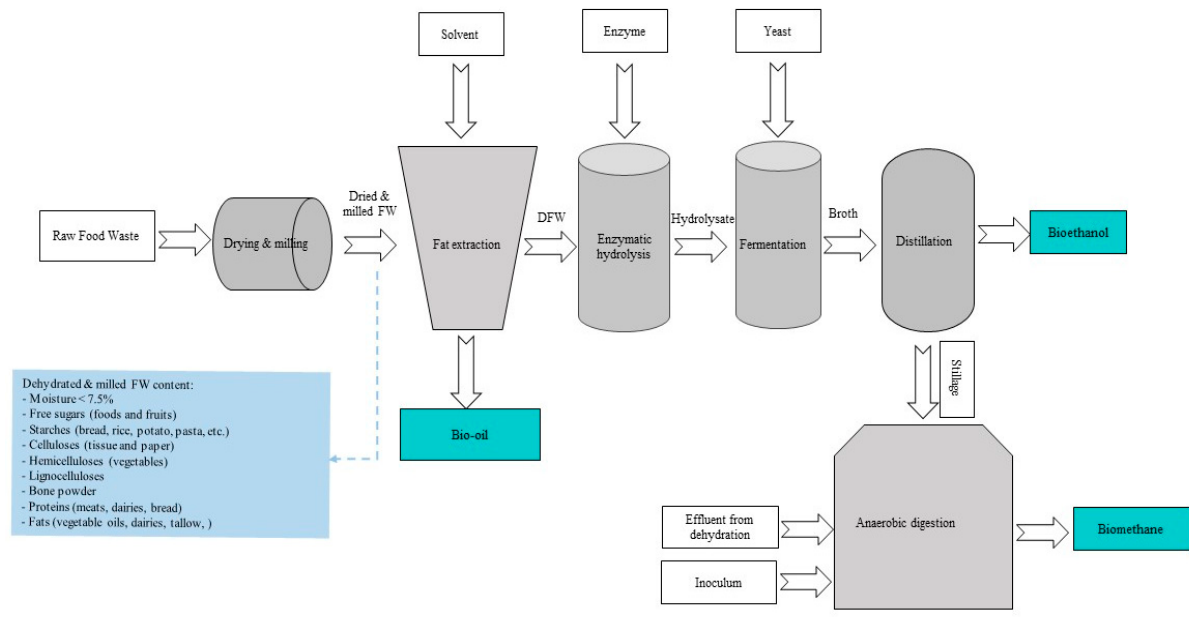
Figure 1. Flow chart of the conversion system.